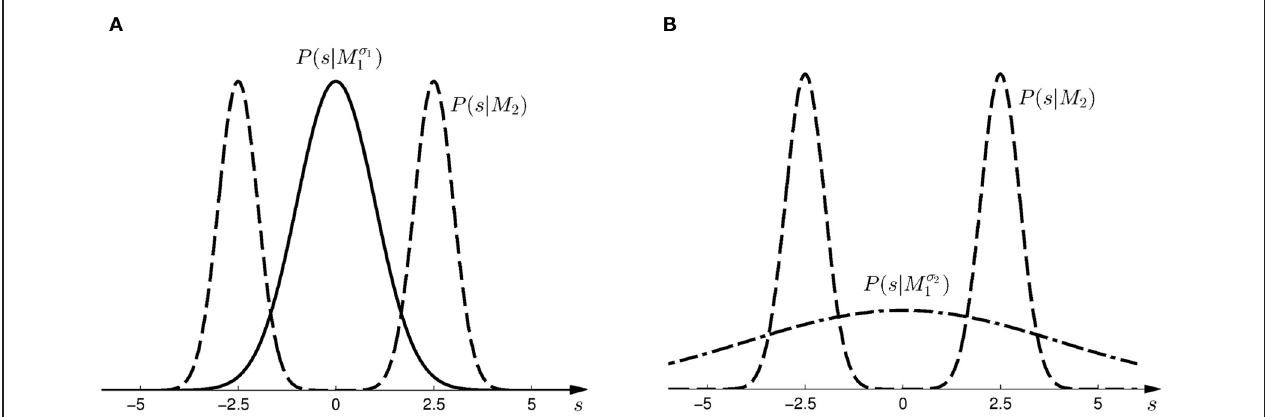
part of the study. (B) Shows the two prior distributions induced by model M σ 2